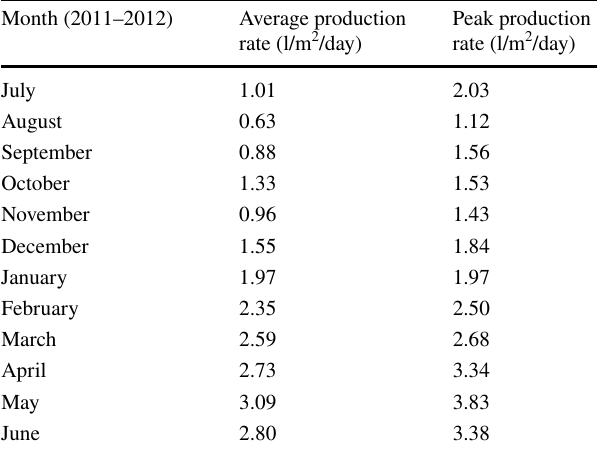
Fig. 4 Typical average monthly temperature and rainfall data in Bangladesh Table 1 Summary of daily production rate of the TSS Month